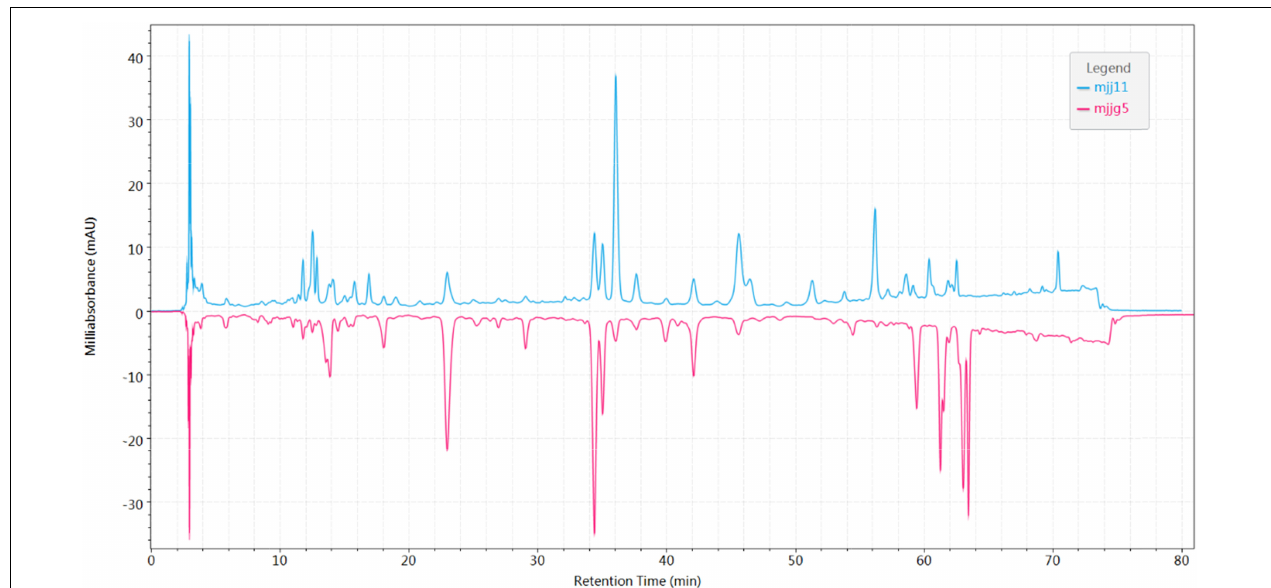
FIGURE 3 | Mirror comparison chromatogram of above-ground parts and roots in Cichorium glandulosum Boiss. et